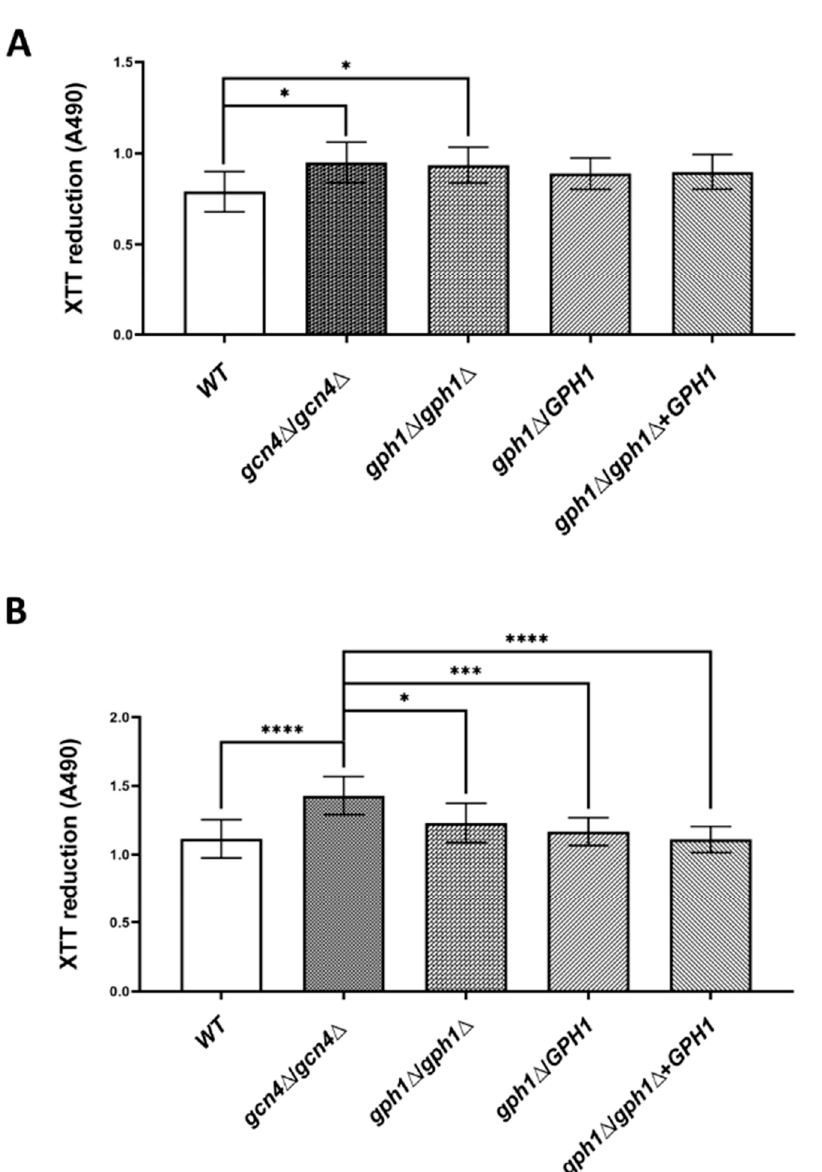
Figure 6. GPH1 has a role in adhesion but not in biofilm formation in C. albicans . Cells of the strains were induced for adhesion in RPMI-1640 medium supplemented with L-glutamine and buffered with MOPS acid as described in the Materials and Methods and were subjected to in vitro XTT reduction assay for adhesion assay ( A ) or biofilm formation assay ( B ). Statistical analyses were performed by one-way ANOVA, with * p < 0.05, *** p < 0.005, **** p < 0.001 as indicated. The GCN4 null mutant gcn4 ∆ / gcn4 ∆ , known to reduce biofilm formation, was included in the